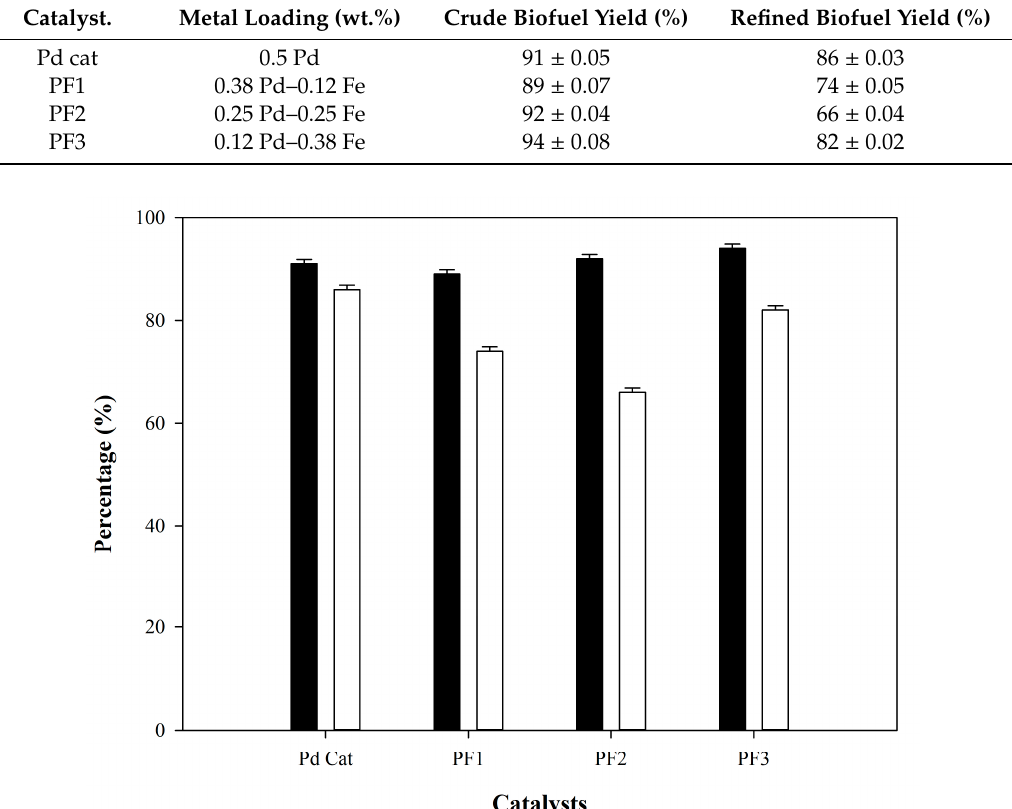
Figure 4. Crude-biofuel yield ( ■ ) and refined-biofuel yield ( □ ) as function of different catalysts used (Pd cat, PF1, PF2, PF3). (Pd cat, PF1, PF2,